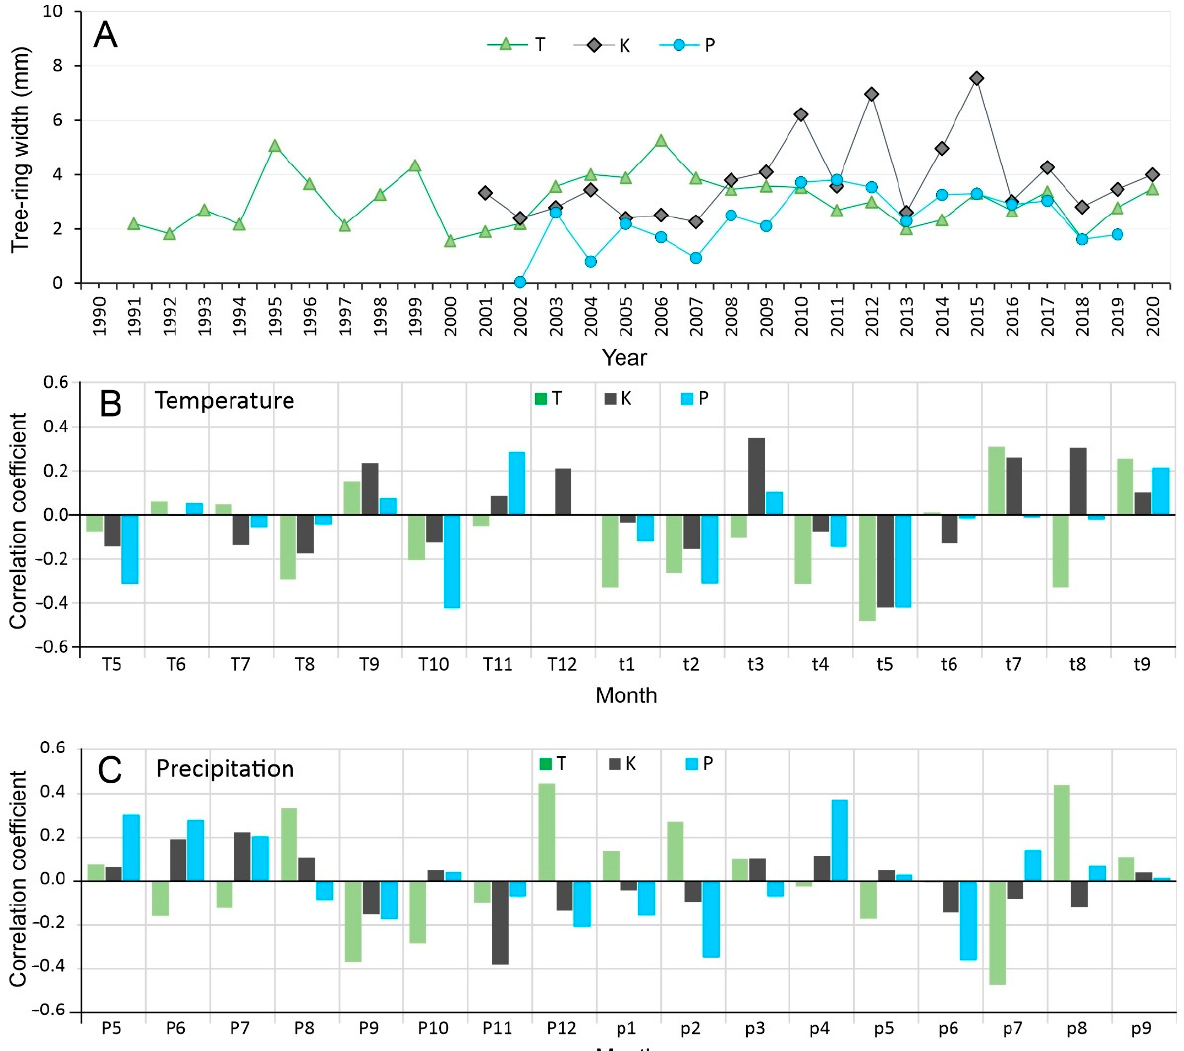
Figure 5. Tree-ring chronologies of Betula pendula from three investigated sites in southern Poland ( A ), with their dendroclimatic responses in terms of mean monthly temperatures ( B ) and monthly precipitation totals ( C ) recorded at Katowice meteorological station. The letters on the x-axis represent months from May of the previous year to September of the current year. Abbreviations: T— reference population from Tychy; K—birch population from post-coal mine spoil heap; P—birch population from post-smelter spoil heap.